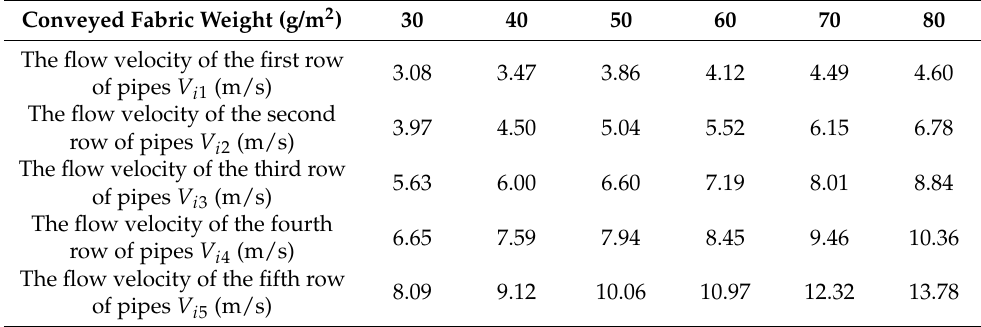
Table 7. The flow velocity of each row of pipe outlet under different fabric weights.